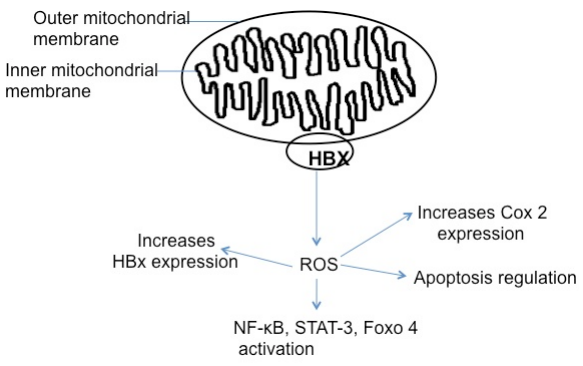
Figure 4. Localization of HBx to mitochondria results in ROS generation. ROS generation by mitochondria can lead to increased apoptosis due to loss of mitochondrial membrane potential. ROS has also been shown to play an important role in HBx induced activation of cell signaling pathways that have been shown to inhibit